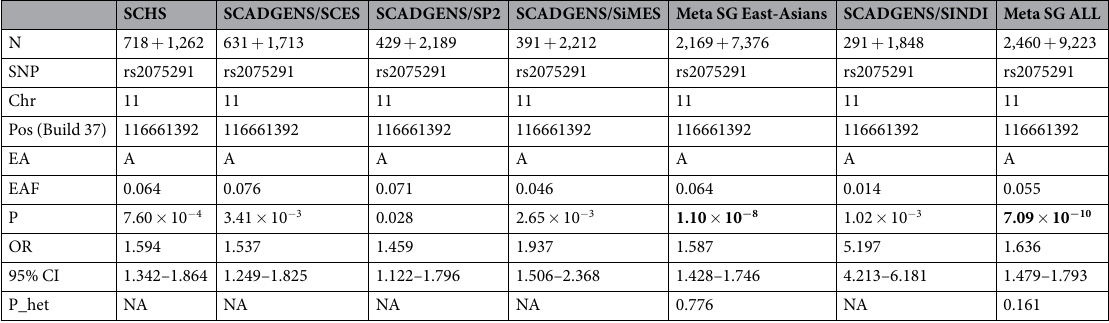
Table 1. Association results for rs2075291 in individual datasets and after meta-analysis procedures. EA: Effect allele; EAF: Effect allele frequency; OR: odds ratio; CI: confidence interval; P_het: P values for Cochran’s